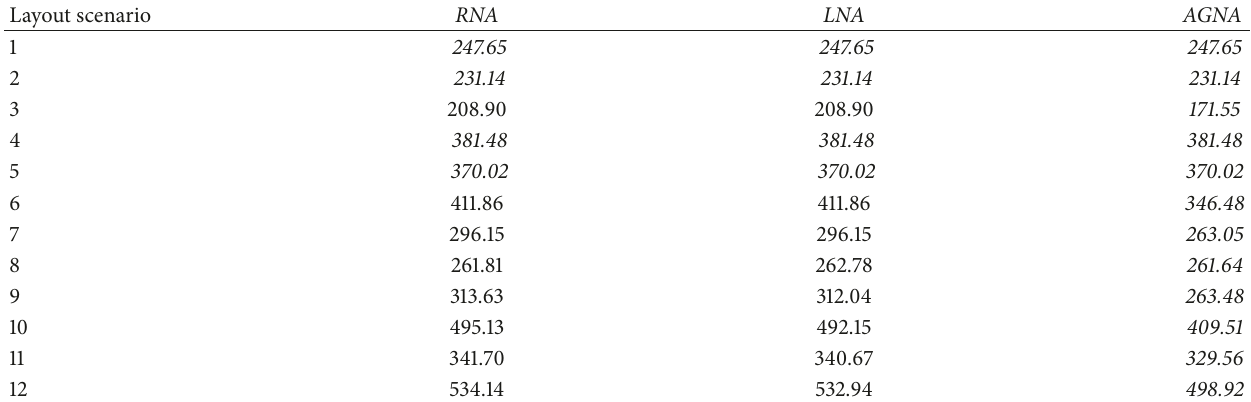
Table 3: The average length of travel distances for all the methods (unit: meter).